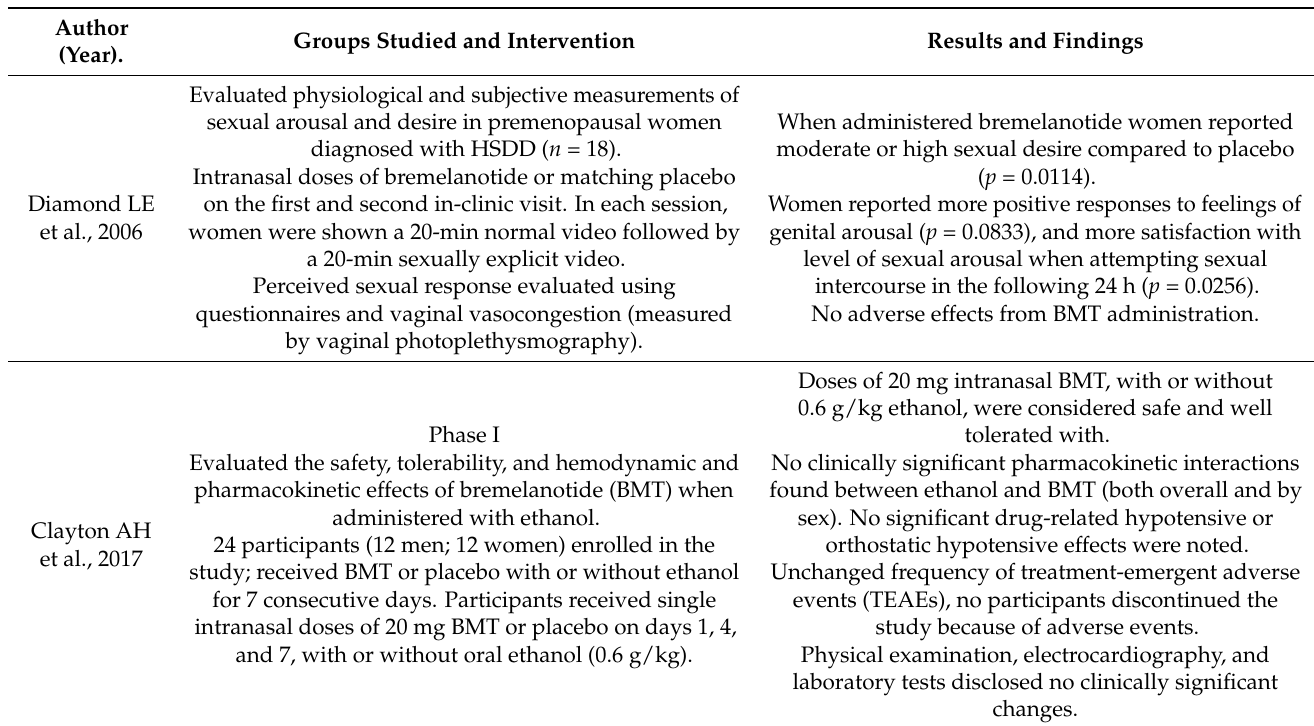
Table 1. Clinical Efficacy and